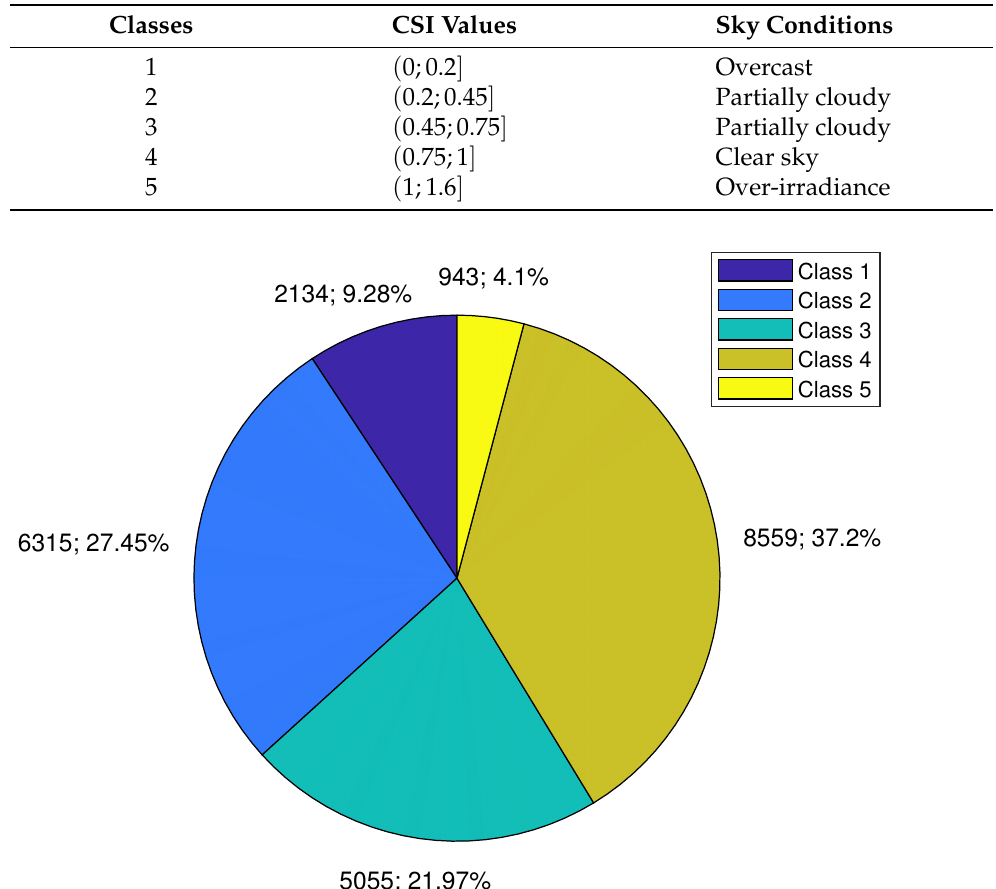
Figure 5. Amount of samples in the five CSI classes with the relevant share of the available